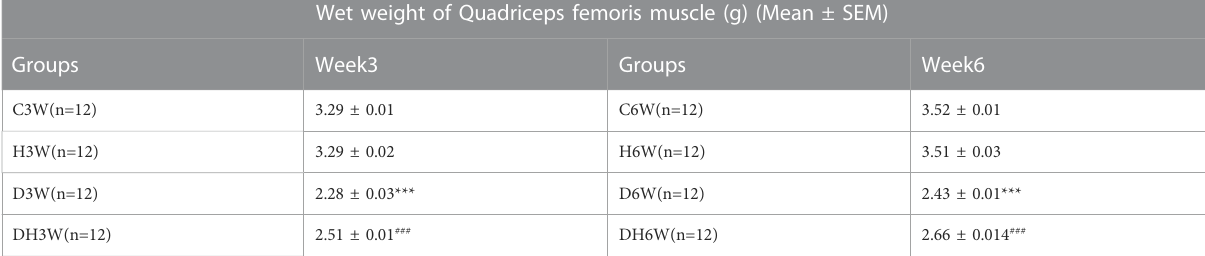
TABLE 3 Wet weight of the quadriceps femoris muscle (g) (Mean ± SEM) measured at the time of tissue collection for morphological and biochemical studies. Note signi fi cantly decreased wet weight of the quadriceps femoris muscle in diabetic groups (D3W and D6W) compared to respective control groups (***, p <